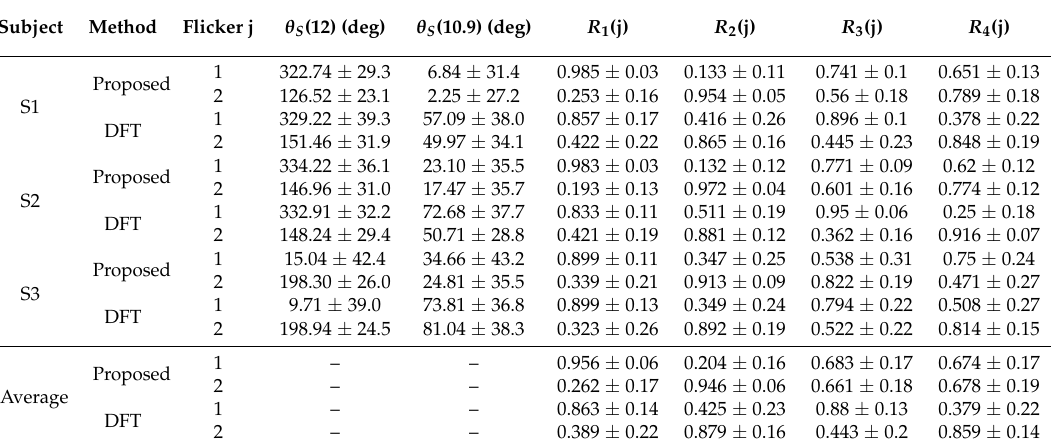
Table 3. The phase and phase feature R j of each subject (mean ±